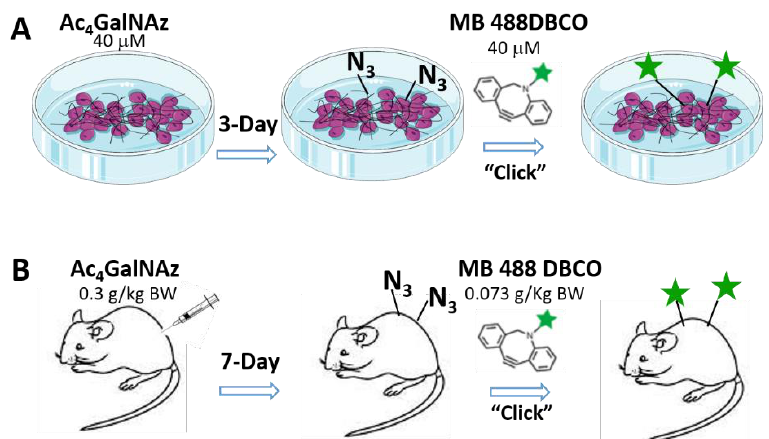
Figure 1. Metabolic labeling of de novo PCM in vitro ( A ) and in vivo ( B ). Cells or animals receive modified sugar molecule (Ac 4 GalNAz) with azide (N 3 ) tags, which can be incorporated during the synthesis of new glycans. The newly synthesized glycans bearing the azide groups can click-react biorthogonally with fluorescent tracers carrying the alkyne group (MB 488 DBCO).